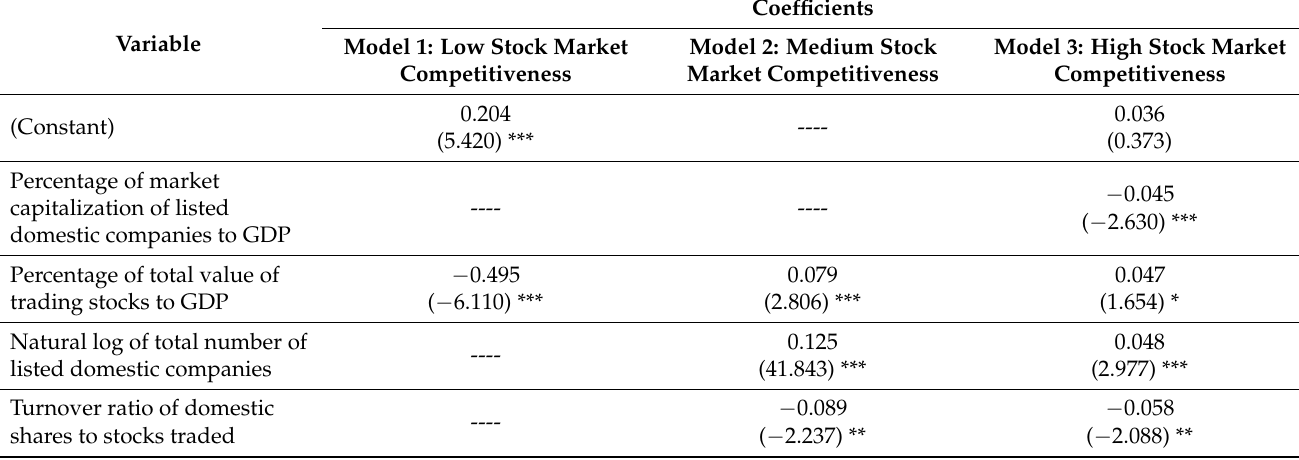
Table 4. Cointegration regression results. The dependent variable is the equity risk premium